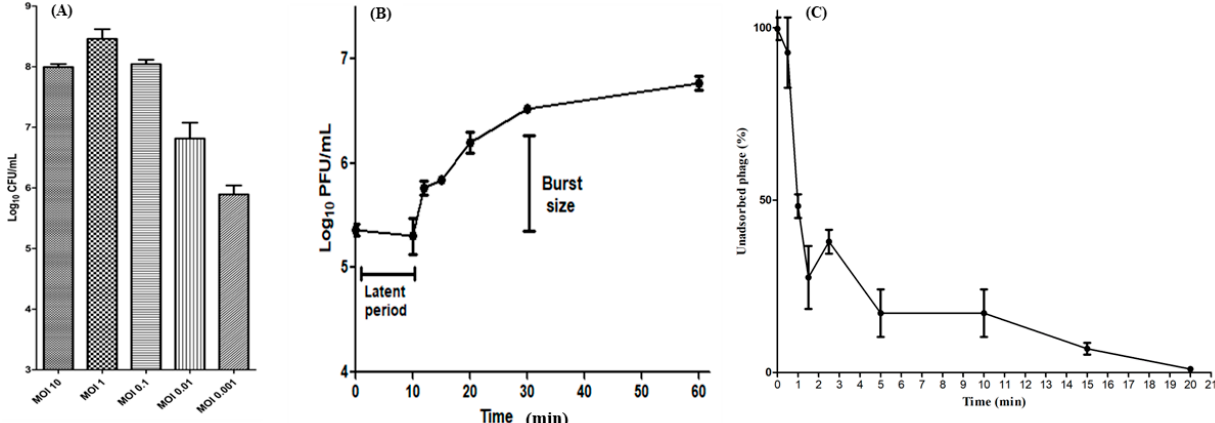
Figure 3. The activity of ZCSE9 against the host bacteria. ( A ) The remained bacteria after six hours by treating them with different MOIs. ( B ) The one-step growth curve of the phage. ( C ) The adsorption curve demonstrates the adsorption percentage over time as measured by the titer of phages remaining in the supernatant.